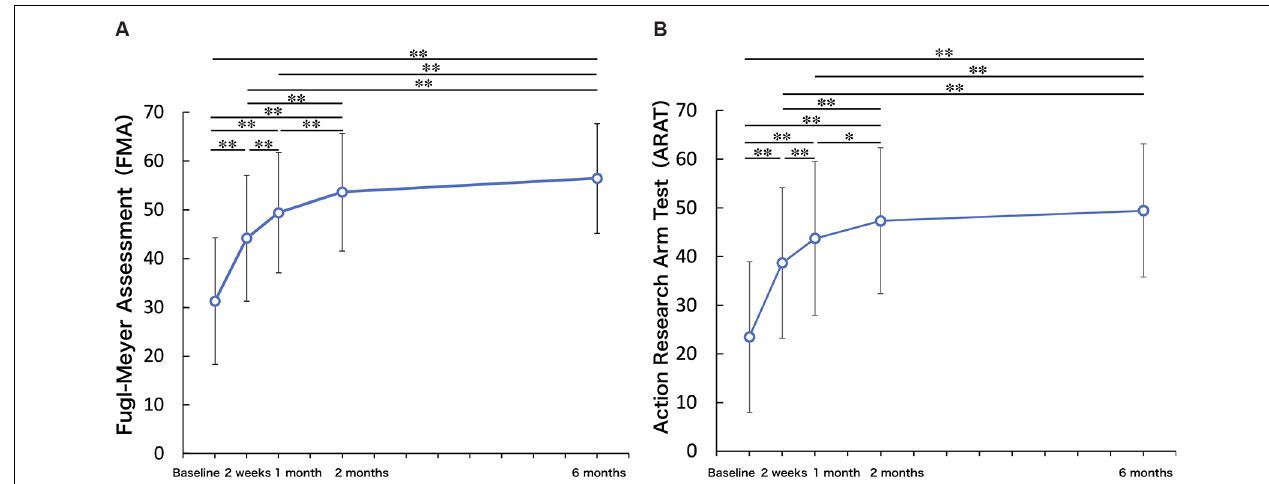
FIGURE 2 | Upper limb function. (A) Fugl-Meyer Assessment (FMA). (B) Action Research Arm Test (ARAT). Upper limb function and ability to manipulate objects improved up to 2 months and were maintained up to 6 months (One-factor repeated-measures analysis of variance (ANOVA), multiple comparison procedure: Bonferroni correction. ∗ p < 0.05, ∗∗ p <